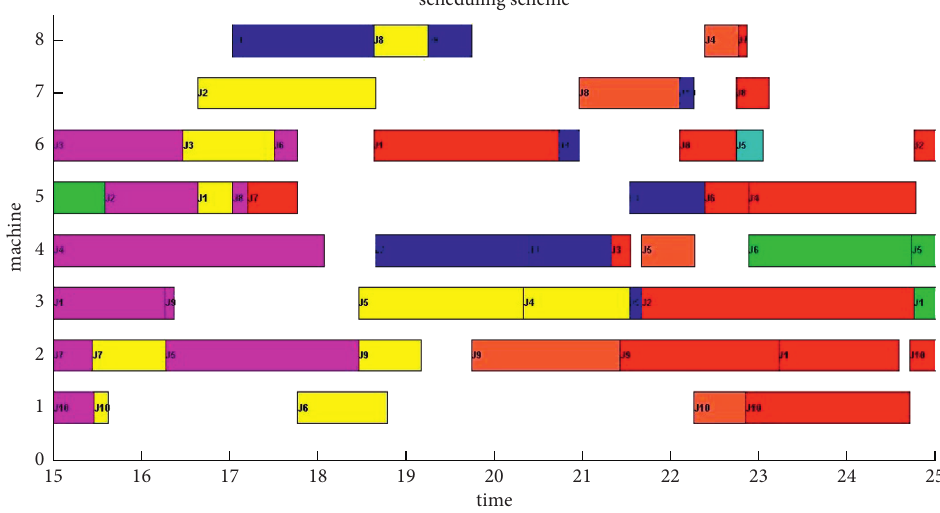
Figure 10: Gantt chart of t � 15 ∼ t � 25 scheduling scheme.